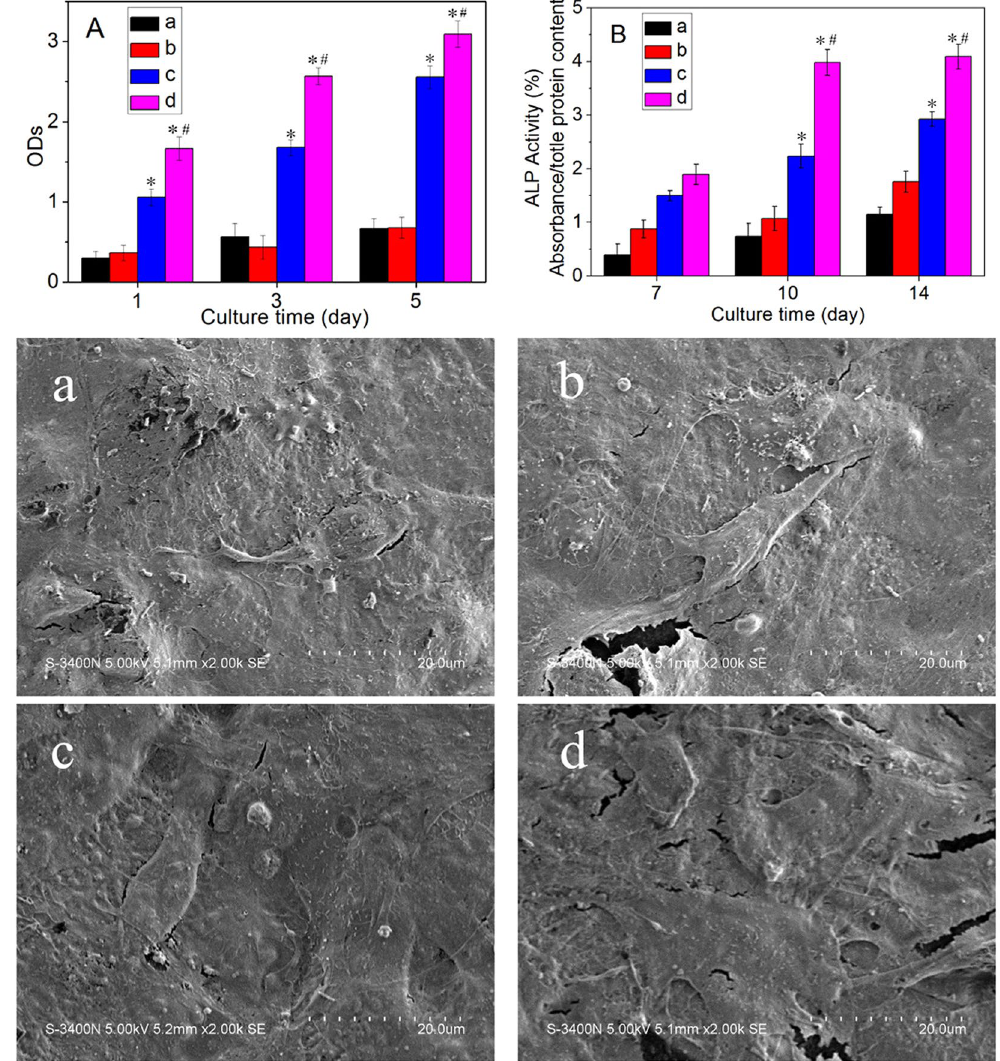
Figure 7. MTT essay ( A ) and ALP activity ( B ) of MG63 cells cultured on MP0 ( a ), MP4 ( b ), MP6 ( c ) and MP8 ( d ) for different time periods. The SEM images show the cell morphology of MG63 cells cultured on MP0 ( a ), MP4 ( b ), MP6 ( c ) and MP8 ( d ) for 5 days. “ * ” denotes significant differences compared to MP0 and MP4,“#” denotes significant differences compared to